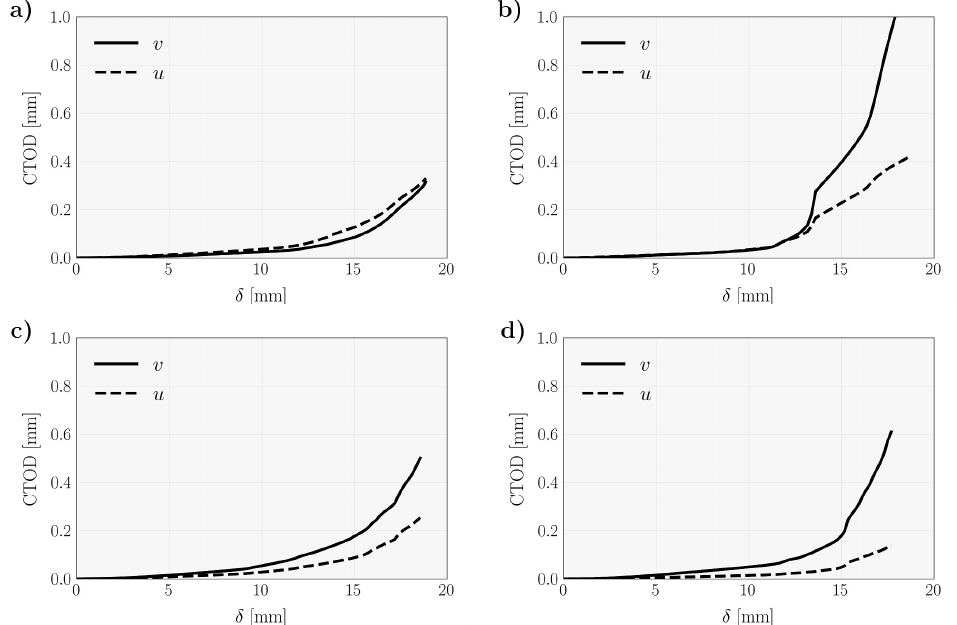
Figure 3. Average crack tip opening displacement (CTOD) as a function of the applied displacement ( v : mode I component of the CTOD; u : mode II component of CTOD), for the global phase angles ( a ) 45 ◦ < θ < 60 ◦ ; ( b ) 60 ◦ < θ < 70 ◦ ; ( c ) 70 ◦ < θ < 80 ◦ ; and ( d ) 80 ◦ < θ < 90 ◦